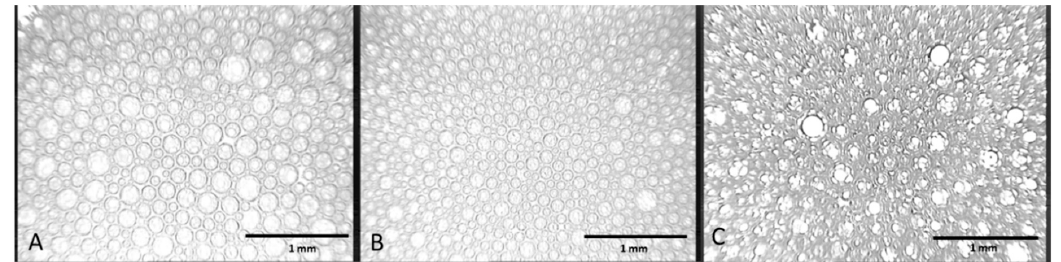
Figure 3. Microscopic scale bidimensional image of foams formed by ( A ) 3% POL, ( B ) 3% POL + 0.3% HA, and ( C ) 3% POL + 0.1 mM F68. Foam samples were produced with the double syringe method standardized protocol (1:4 liquid/air, 50 cycles, 0.9% NaCl, and 20 °C), and the images were taken after 1 min.